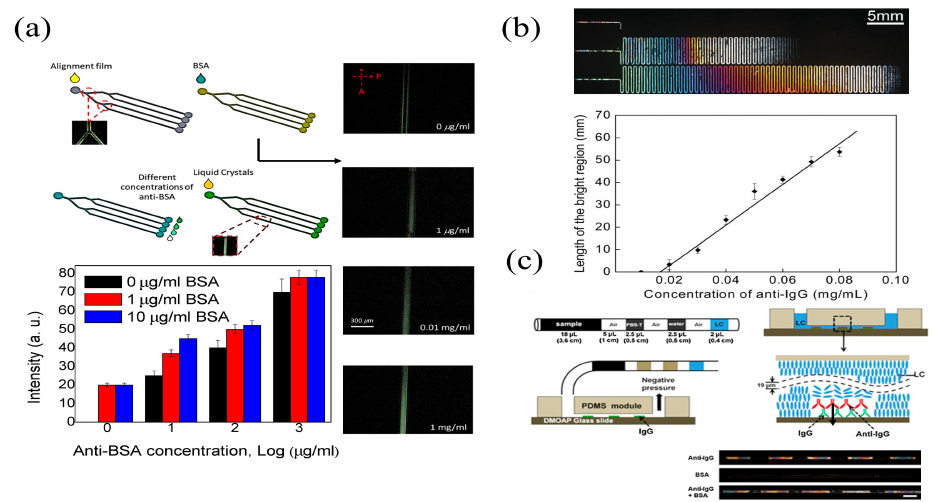
Figure 3. ( a ) Schematic of multi-microfluidic LC immunoassays with optical images of POM at different concentrations of BSA and intensities of LC microfluidic chips with BSA at concentrations of 0, 1, and 10 µ g mL − 1 [91]; reproduced with permission from Fan et al. ( b ) POM images of the IgG modified LC–solid interface microfluidic platform, and the linear characterization between the length of bright region and the IgG antibody concentration [92]; reproduced with permission from Wiley. ( c ) Diagram of the microfluidic LC sensor for automated immunoassays [93]; reproduced with permission from